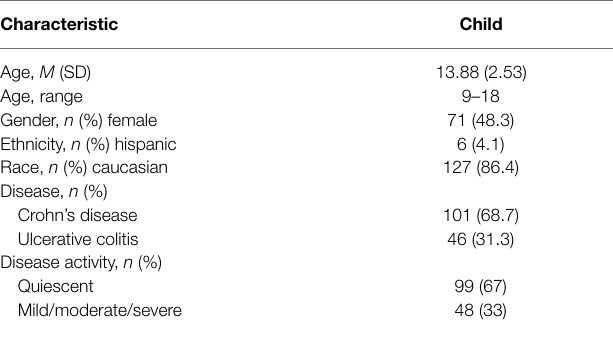
TABLE 1 | Sample characteristics ( n = 147 pediatric patients with